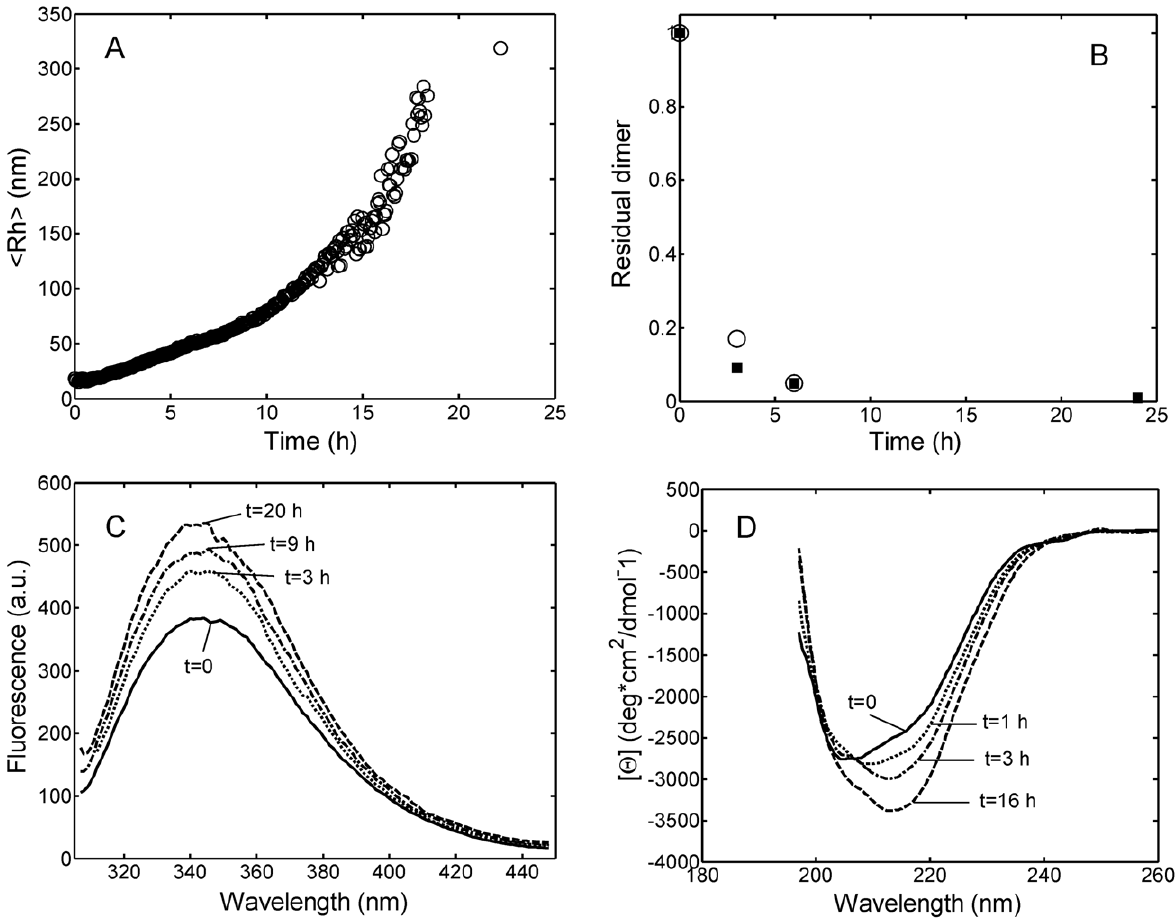
Figure 5. Aggregation kinetics of light chain solution in 20 mM HCl at pH 2.0, T=37 6 C, with 0.15 M Na 2 SO 4 (run 8 in Table 1). Time evolutions of (A) the average hydrodynamic radius , R h . , measured on-line by in situ DLS; (B) residual massive dimer fraction ( m ) evaluated by SEC ( & ) and FFF ( # ); (C) Intrinsic tryptophan spectra; (D) CD spectra. Experiments were performed at a protein concentration of 1 g/L for (A) and (B) and 0.3 g/L for (C) and